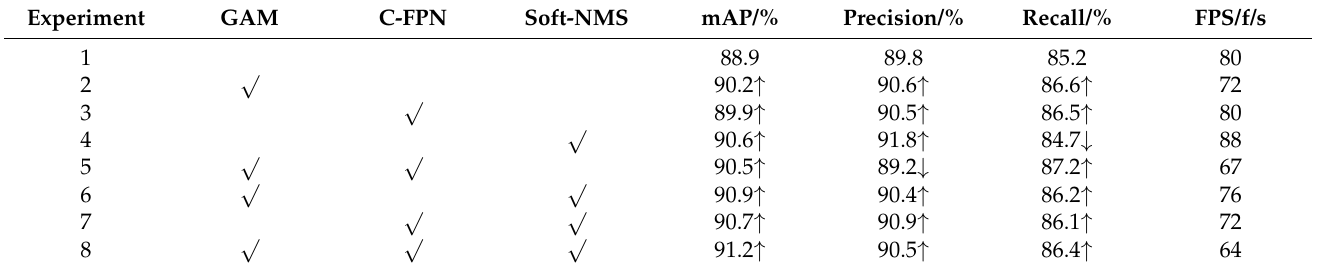
Table 2. Results of ablation